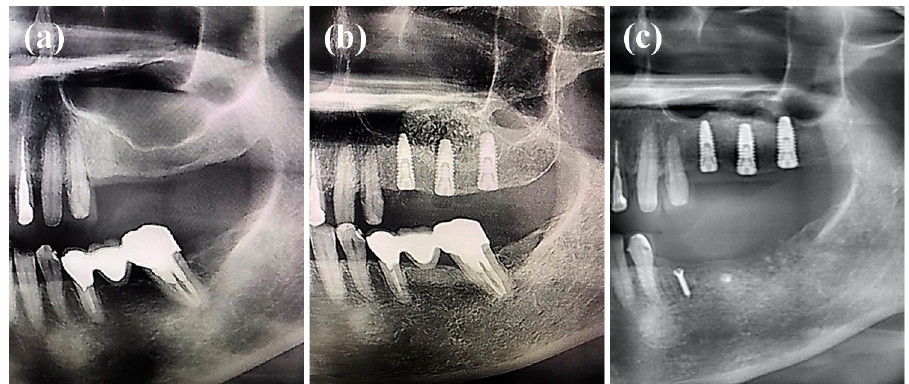
Figure 6. Panoramic images: ( a ) before treatment, ( b ) immediately after treatment, and ( c ) six months after treatment.